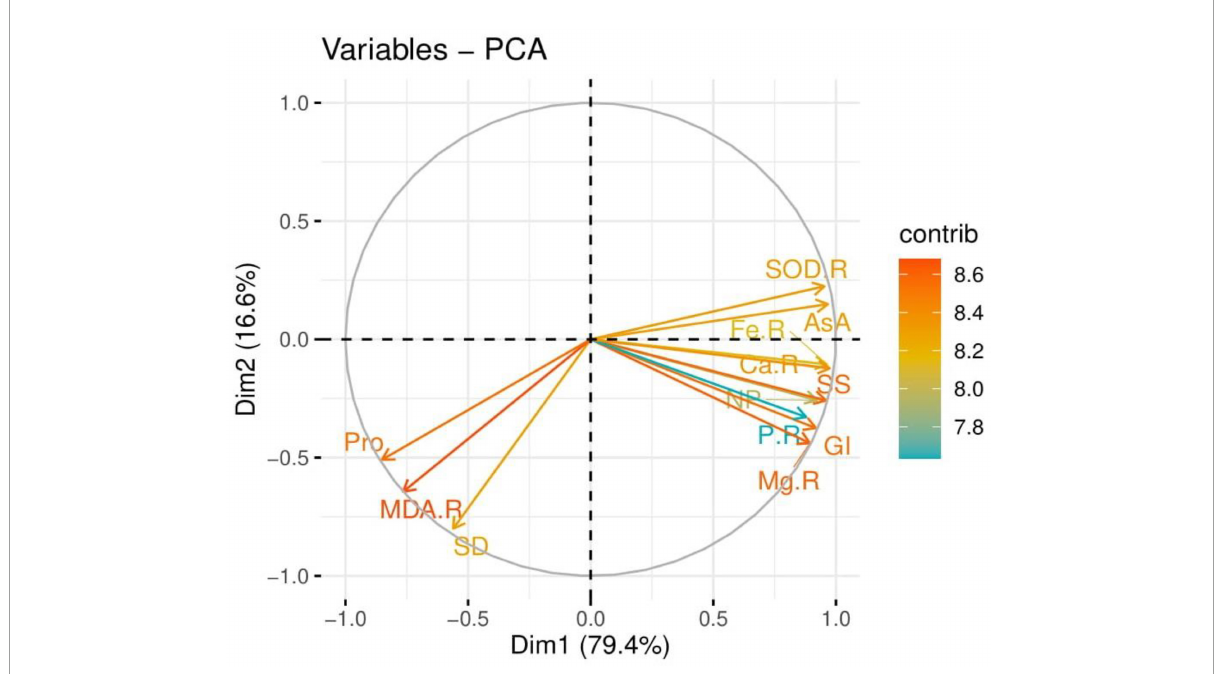
FIGURE10 Loading plots of principal component analysis (PCA) on different studied attributes of wheat grown under well-watered and drought-stressed environment with various application levels of Plantago ovata Forsk leaf extract (POLE). Different abbreviations used are as follows: Ca-R, calcium contents in the roots; Fe-R, iron contents in the roots; P-R, phosphorus contents in the roots; Mg-R, magnesium contents in the roots; SS, soluble sugar; AsA, ascorbic acid contents; SOD-R, superoxidase dismutase activity in the roots; NP, net photosynthesis; GI, germination index; Pro, proline contents; SD, stomatal density; and MDA-R, malondialdehyde contents in the roots.